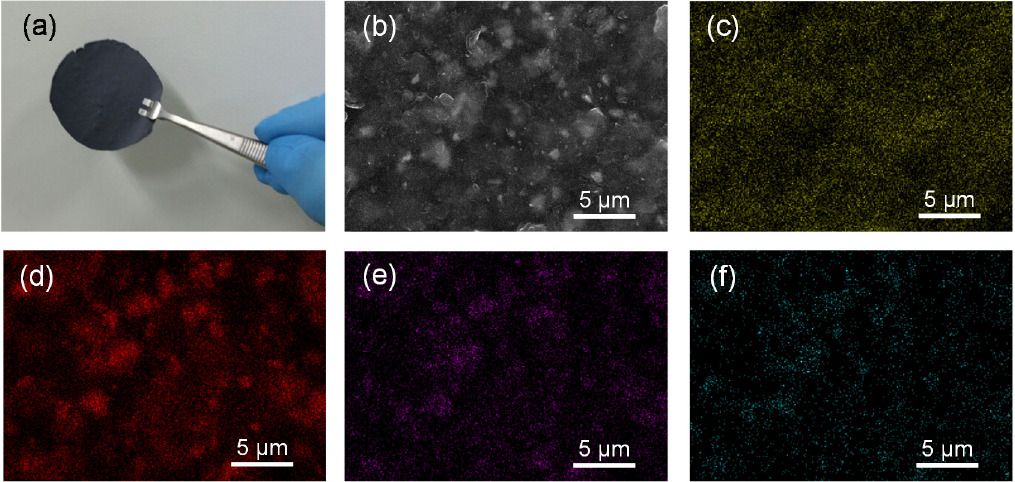
Figure 2. ( a ) Photograph and ( b ) field emission scanning electron microscopy